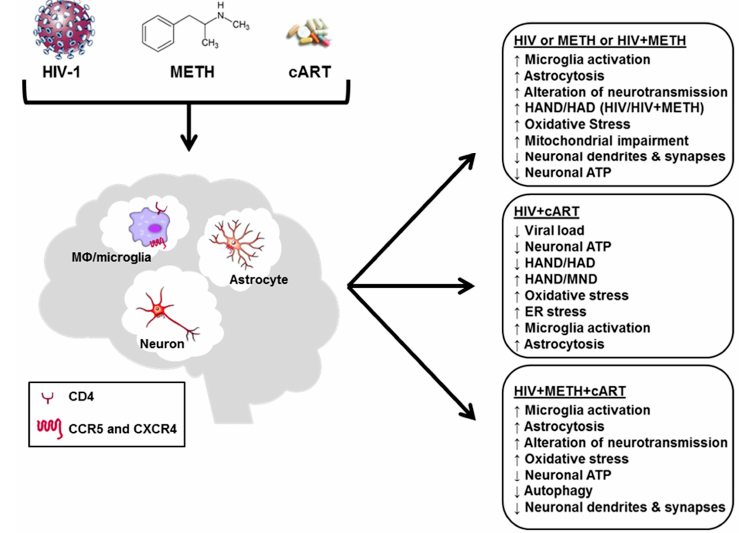
Figure 1. Treatment of HIV-1 infection with cART greatly reduces viral loads in periphery and the central nervous system (CNS), the incidence of HIV-associated dementia (HAD) and acquired immunodeficiency syndrome (AIDS)-related deaths. HIV-1 or its components, methamphetamine (METH) and some antiretrovirals used in combined antiretroviral therapy (cART) can induce oxidative and endoplasmic retriculum (ER) stress, compromise autophagy and neuronal energy homeostasis and trigger functional as well as structural neuronal injury. However, even without overt structural damage, diminished adenosine triphosphate (ATP) levels indicate that neurons may lose, at least in part, the energy reserve that is vital to maintaining their normal membrane potential and physiological functions, such as homeostatic regulation of neurotransmission. A compromised neuronal energy homeostasis may explain why cART permits the occurrence of HIV-associated mild neurocognitive disorders (MND). Interestingly, neuronal energy levels can apparently drop significantly during exposure to some drugs or combinations thereof without necessarily destructing neuronal dendrites and pre-synaptic terminals, suggesting that a restoration of full neuronal function may be possible.